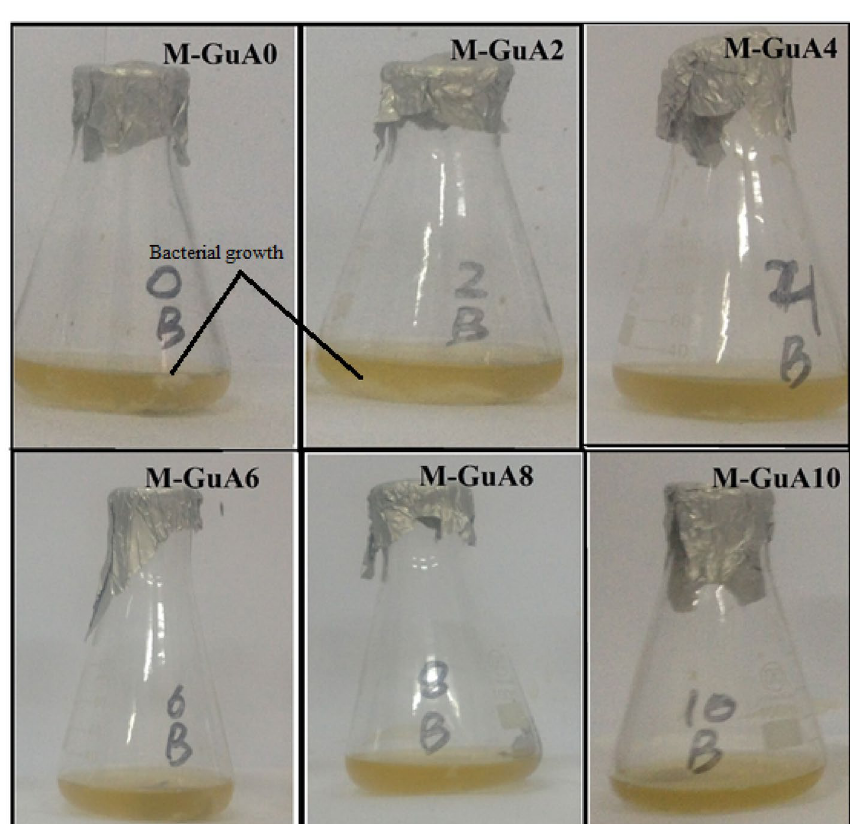
Figure 8. Bio-fouling of M-GuA